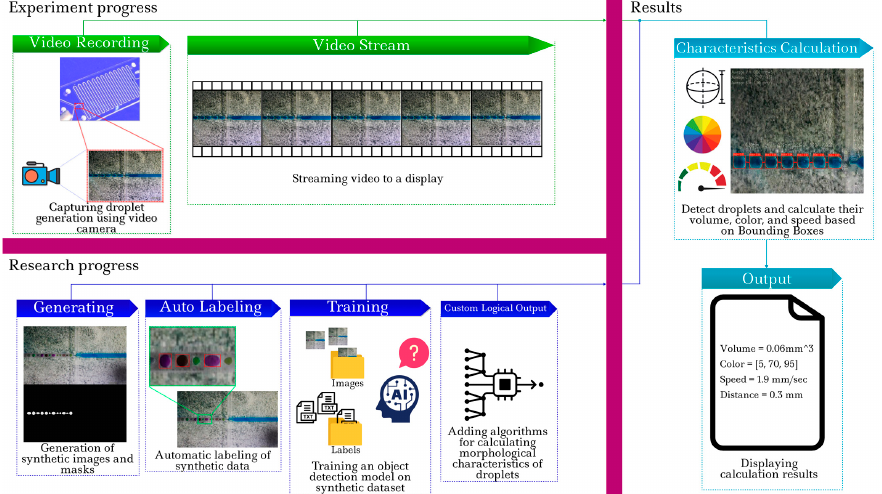
Figure 12. The main steps of the proposed methods. Big Data Cogn. Comput. 2023 , 7 , x FOR PEER REVIEW